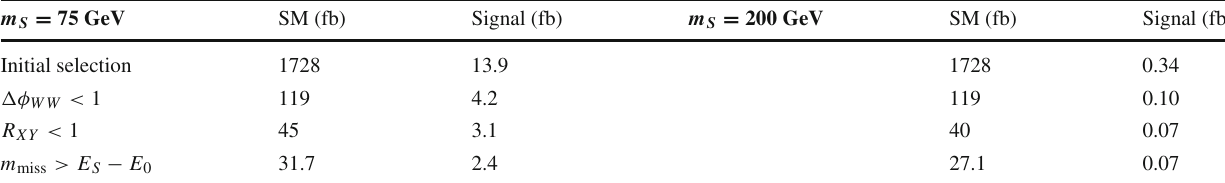
Table 2 Signal (for λ HS = 1) and SM background cross sections (in fb) for the non-idealized luminosity spectrum L nc γγ ( y ) for CLIC with √ s | ee = 3 TeV, after the initial event selection (4 hadronic jets with